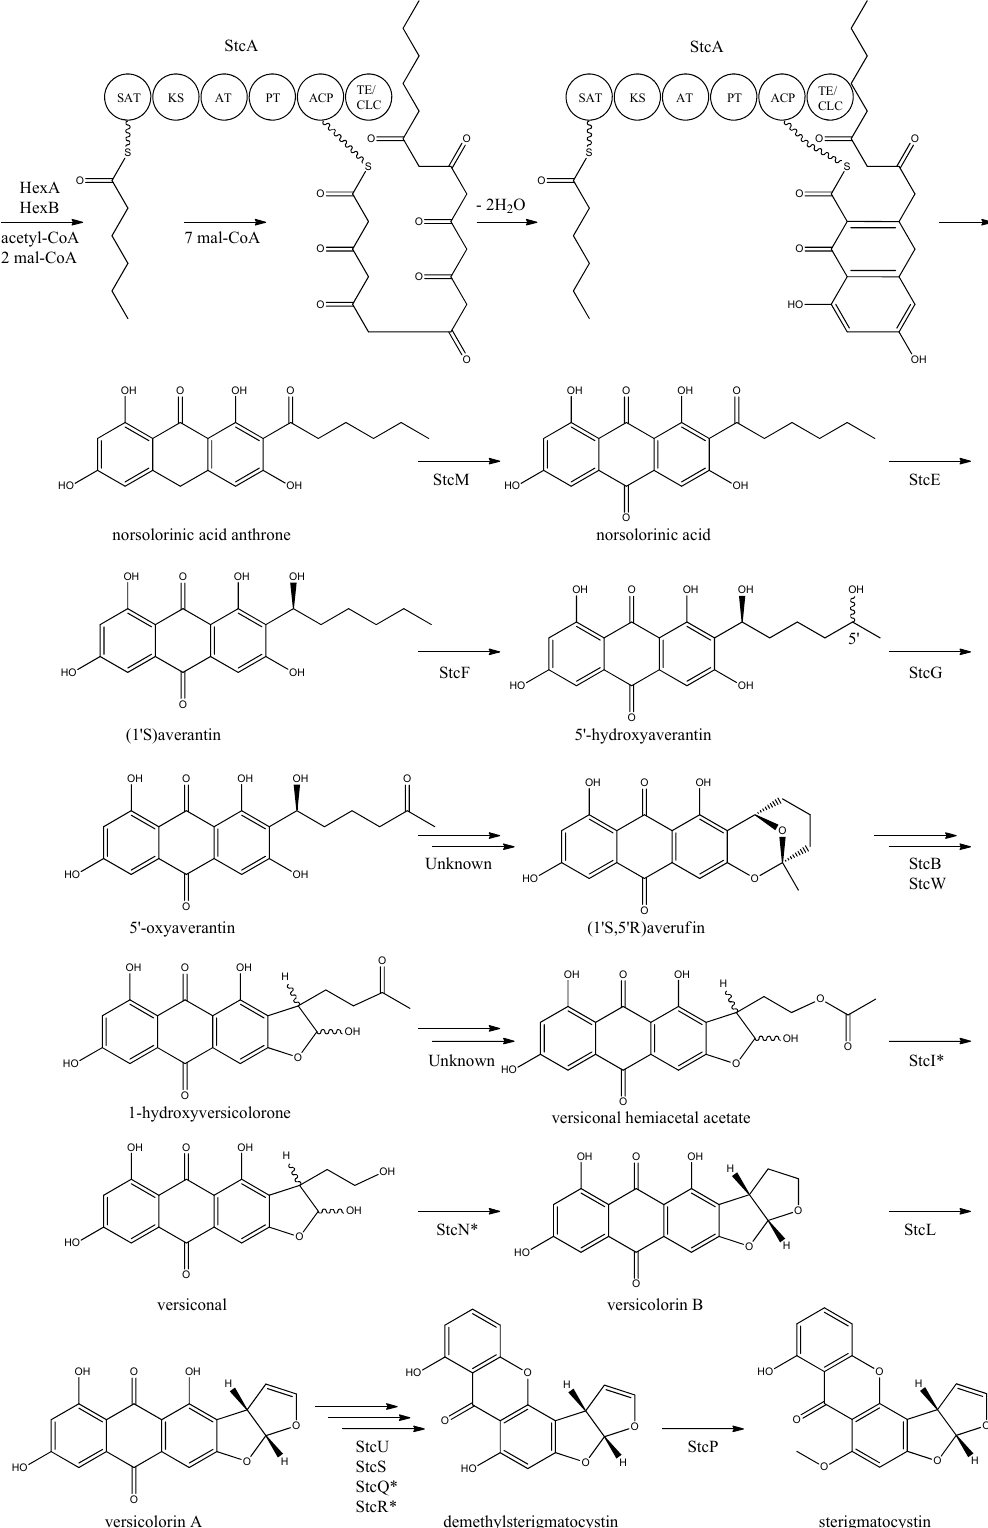
Figure 4. Proposed biosynthesis of sterigmatocystin. StcA contains starter unit-ACP transacylase (SAT), β -ketosynthase (KS), acyltransferase (AT), product template (PT), acyl carrier protein (ACP) and thioesterase/claisen cyclase (TE/CLC) domains. *Indicates a proposed, but not confirmed, enzyme. Multiple arrows indicate that the number of enzymatic steps is